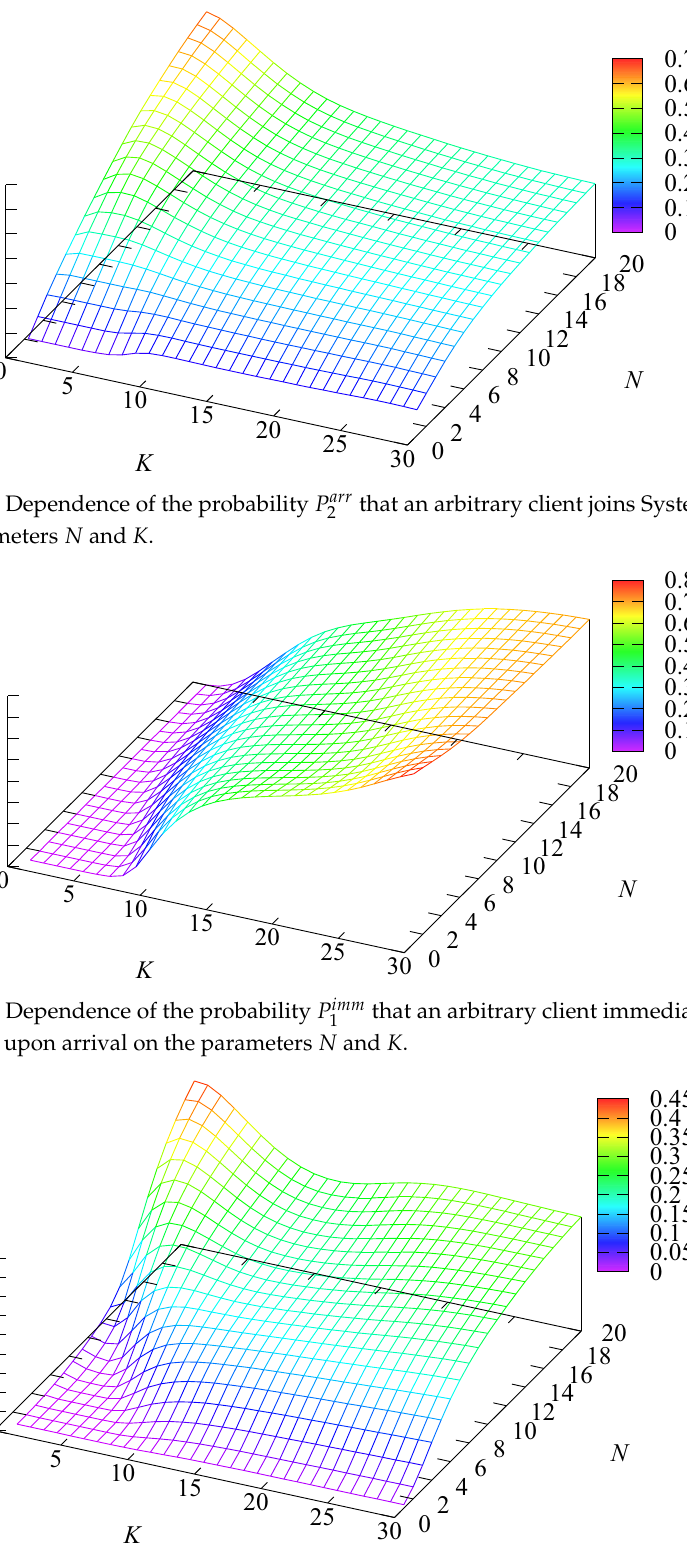
that an arbitrary client immediately starts service in 2